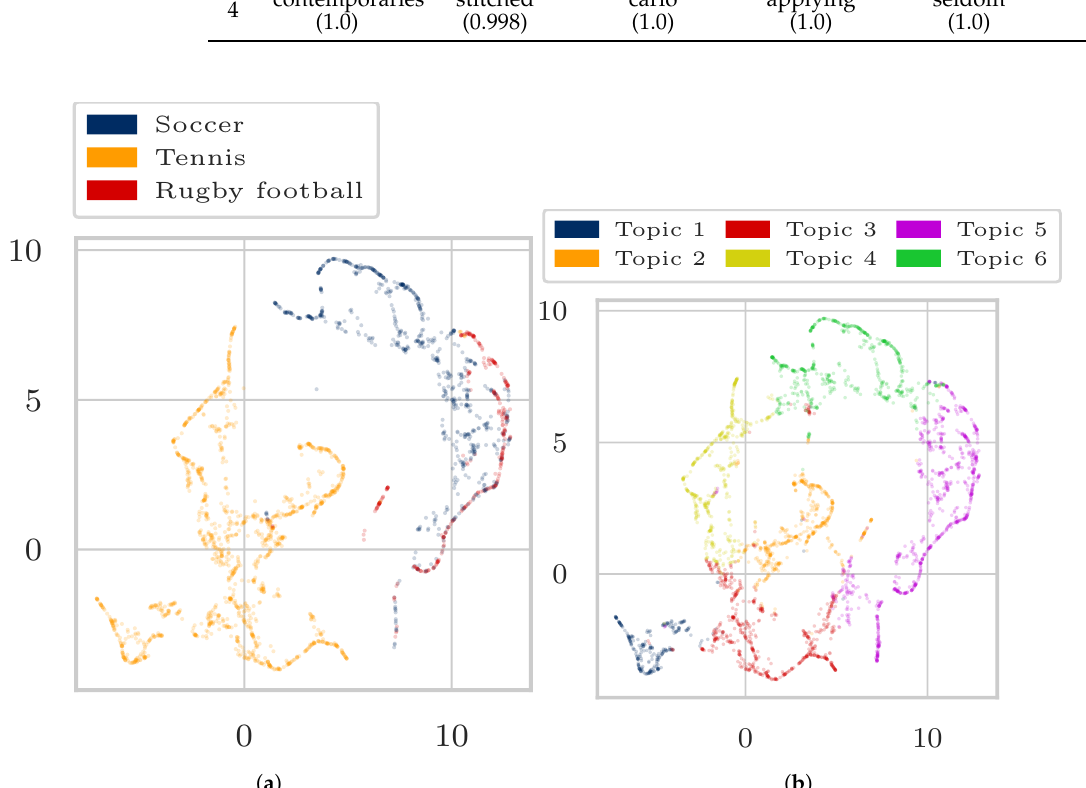
Figure A9. ( a ) 2-dimensional representation of word embeddings H colored by topic assignment. ( b ) 2-dimensional representation of word embeddings H colored by original Wikipedia article assignment (words that occur in more than one article are